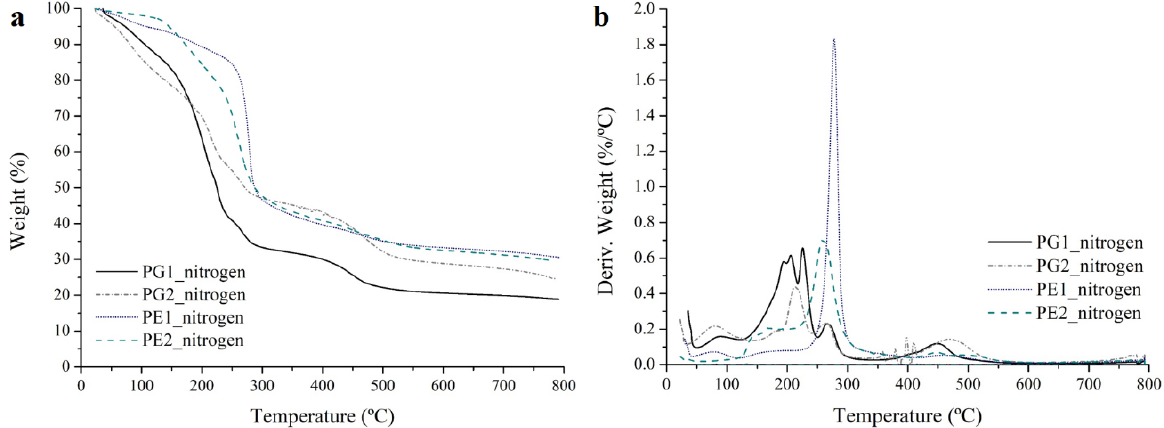
Polymers 2023 , 15 , x FOR PEER REVIEW 12 of 21 Figure 9. ( a ) TGA and ( b ) DTG data for the different monomers and polymers in nitrogen.